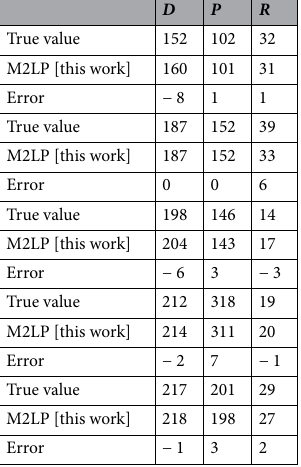
Table 3. M2LP-based estimation of the characteristic parameters in comparison with their true values for selected test scenarios. Explanation of terms: D —depth, P —lateral position, R —radius (all in mm).